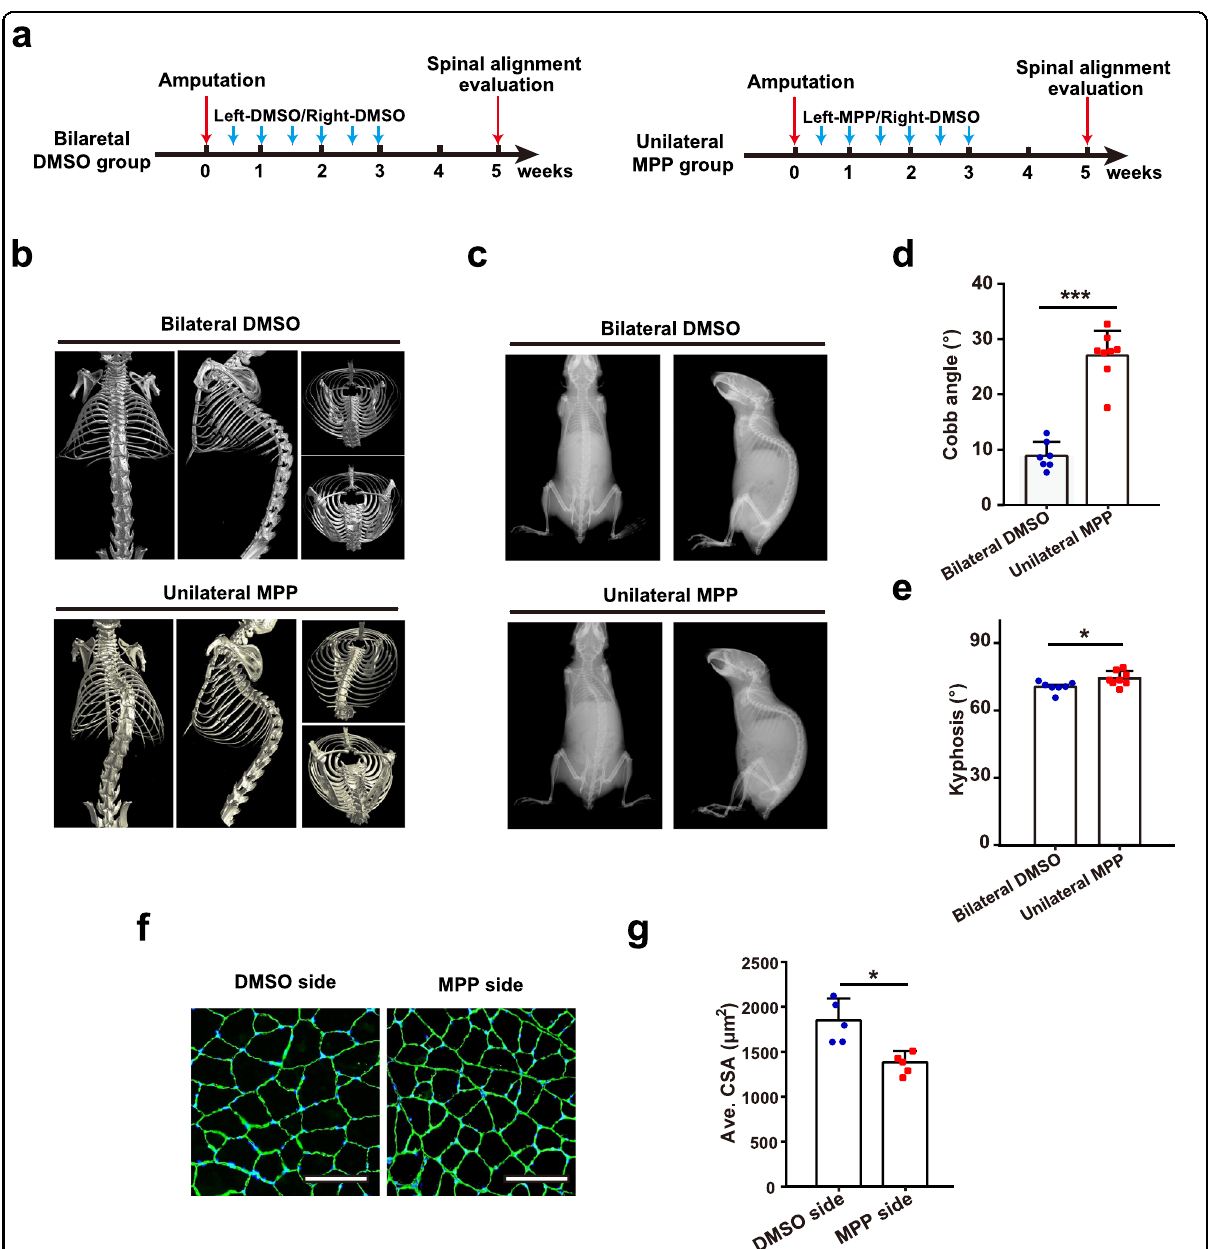
Fig. 4 Asymmetric inactivation of ESR1 in para-spinal muscle leads to scoliosis. a Scheme of unilateral MPP treatment. Bipedal mice of 3 weeks old were subjected for unilateral intramuscular injection of MPP at the left side of the para-spinal muscle, while DMSO was injected to the opposite side. Continuous injections were performed twice every week for 3 weeks. The spinal alignment was evaluated 5 weeks after the fi rst MPP injection. b Micro-CT images for spinal alignment and thoracic cage symmetry evaluation in bilateral DMSO and unilateral MPP group 5 weeks after the fi rst MPP injection. c In vivo X-ray images of spinal alignment in bilateral DMSO and unilateral MPP group 5 weeks after the fi rst MPP injection. d Statistical analysis of Cobb angle in coronal plane for bilateral DMSO group ( n = 7) and unilateral MPP group ( n = 8) 5 weeks after the fi rst injection. Error bars indicated standard deviation. *** P < 0.001. e Statistical analysis of kyphosis in sagittal plane for bilateral DMSO group ( n = 7) and unilateral MPP group ( n = 8) 5 weeks after the fi rst injection. Error bars indicated standard deviation. * P < 0.05. f Representative immuno fl uorescent staining of para-spinal muscle sections from unilateral MPP group. Cryosections were obtained from the para-spinal muscles isolated from the DMSO injection side and MPP injection side. The cryosections were stained with anti-Laminin antibody. Green indicated laminin; Blue indicated DAPI staining of nuclei. The merged images were shown. Scale bars: 100 μ m. g Statistical analysis of the CSA of myo fi bers from unilateral MPP group. At least 400 fi bers were analyzed for each sample. Error bars indicated standard deviation ( n = 5). * P <